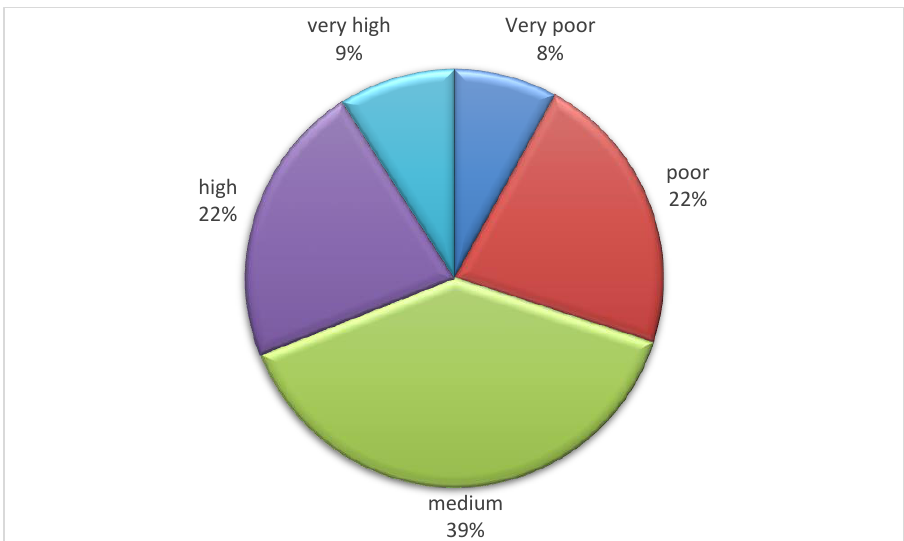
Figure 1. Ibnu Thufail Students’ HOTS based on Judgment and Critical Thinking Indicator in Percentage